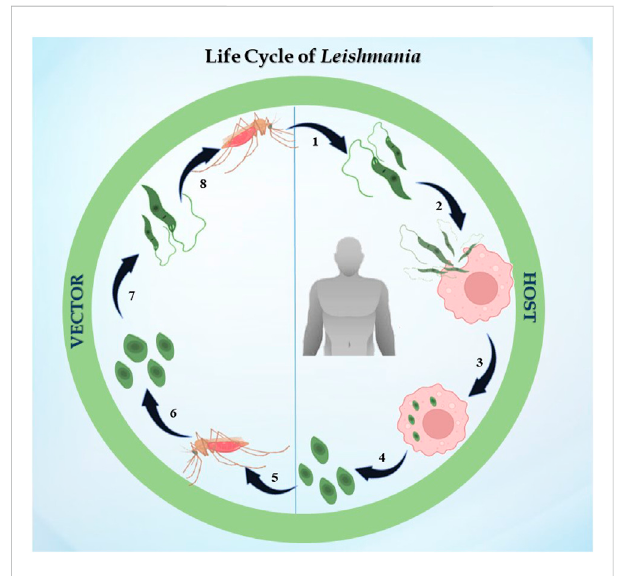
FIGURE 1 Life cycle of Leishmania : the fi gure represents the digenetic life cycle of 1. promastigotes injected in the host by sand fl y, 2. promastigotesengulfedbymacrophagesofthehost,3.promastigotes transformed into amastigotes inside macrophages, 4. amastigotes transmitted to other healthy macrophages, 5. an infected sand fl ytakingitsnextbloodmeal,6.amastigotestransformingintothe promastigote stage in the midgut, 7. dividing into the midgut and migrating to the proboscis, and 8. the life cycle